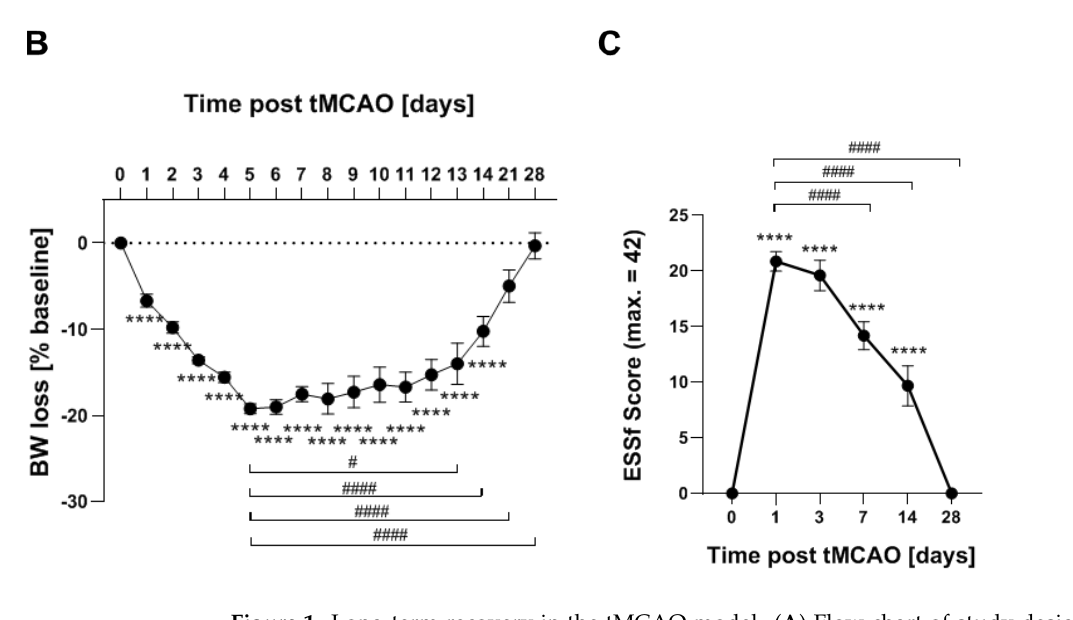
Figure 1. Long-term recovery in the tMCAO model. ( A ) Flow chart of study design. ( B ) Weight loss tMCAO surgery presented as percentage reduction from preoperative body weight ± SEM n = 25, **** p < 0.0001 vs. baseline, # p < 0.05, #### p < 0.0001 vs. d5. One-way ANOVA with Bartlett correction. ( C ) ESSf scores for mice taken at the indicated days after stroke induction ± SEM. n = 25, **** p < 0.0001 vs. baseline, #### p < 0.0001 vs. d5. One-way ANOVA with Bartlett